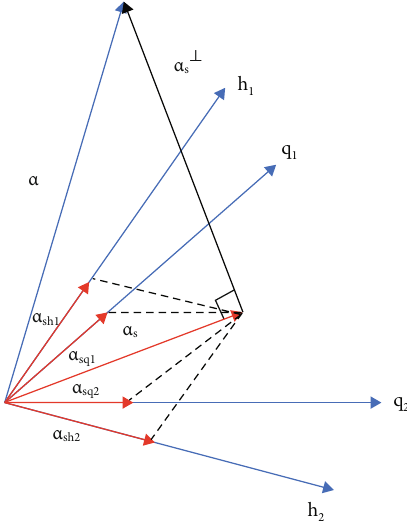
Figure 3: Schematic diagram of determining the optimal navigation